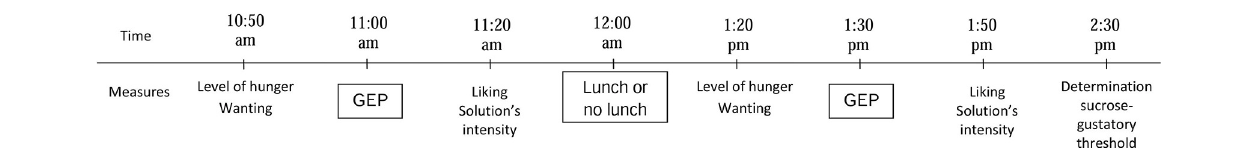
FIGURE 2 | Design of the experiments. To measure hunger, wanting, liking ratings, and perceived intensity of the sucrose solution, the subjects had to answer the four following questions: “Are you hungry?,” “Do you feel like eating?,” “How palatable was the sucrose solution?,” and “How intense was the sucrose solution?,” The responses were scored using a 10-cm visual analog scale ranging from “Not at all” to “Extremely.” The same measurements in that order were performed in the two separate sessions (feeding and fasting). (GEP, Gustatory-evoked potentials).